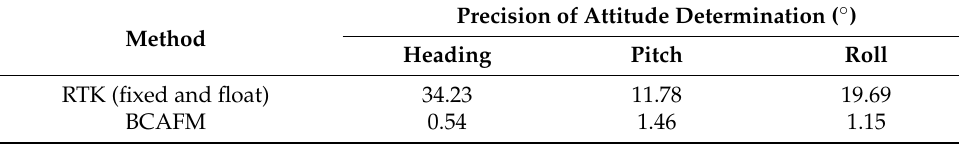
Table 7. The Precision of attitude determination based on BCAFM and